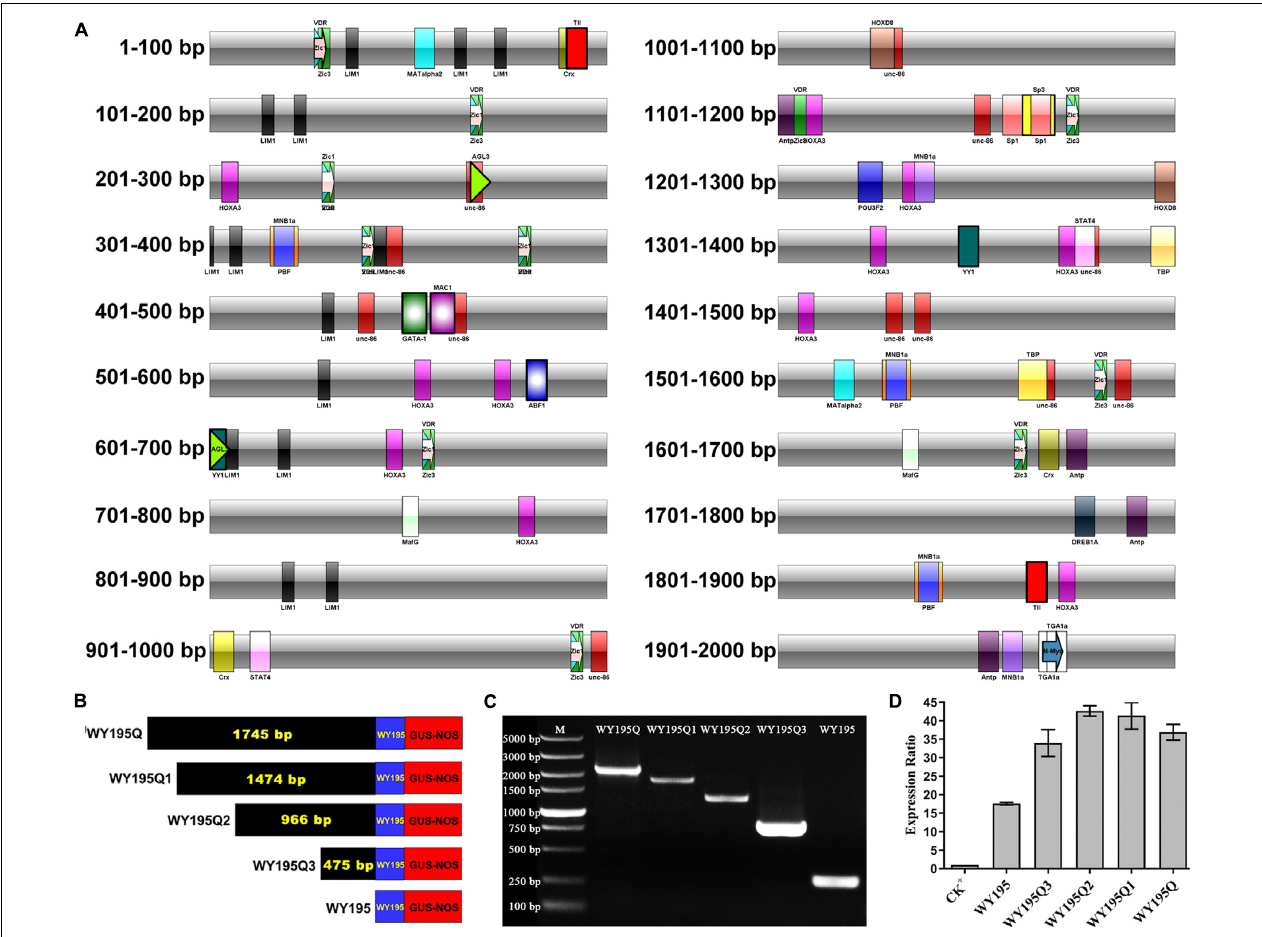
FIGURE 7 | Preliminary analysis of the full length of WY195 by a series of deletion mutations. (A) Detailed distribution of transcription factor binding sites on the WY195Q sequence. (B) Schematic diagram of fusion of the 5 (cid:48) series deletion fragment of WY195Q with the GUS gene. (C) PCR verification of the WY195 promoter series deletion mutant vector. (D) WY195Q series deletion mutant fragment drives the transient expression of GUS gene in N. tabacum. TABLE 4 | Primers for WY195Q series deletion mutation. Fragments Upstream primers Downstream